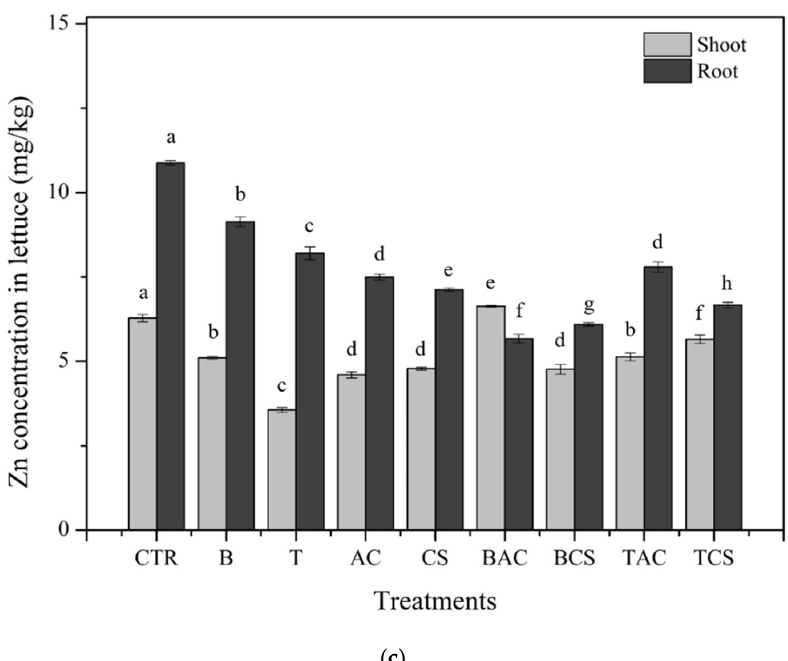
Figure 6. Arsenic, Cu, and Zn concentration uptake by lettuce with the presence of various amend- ment treatments after 45 days. Means with the same letters are not significantly different from each other under different amendment treatments according to Tukey’s test ( p < 0.05, n = 3) (CTR: control, B: bentonite, AC: activated carbon, CS: cornstarch). ( a ) Arsenic in lettuce tissue, ( b ) Copper in lettuce tissue, ( c ) Zinc in lettuce tissue.